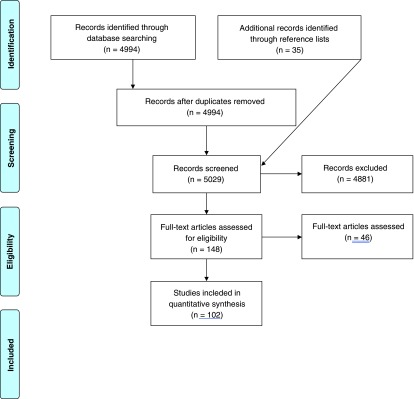
PRISMA flow diagram.